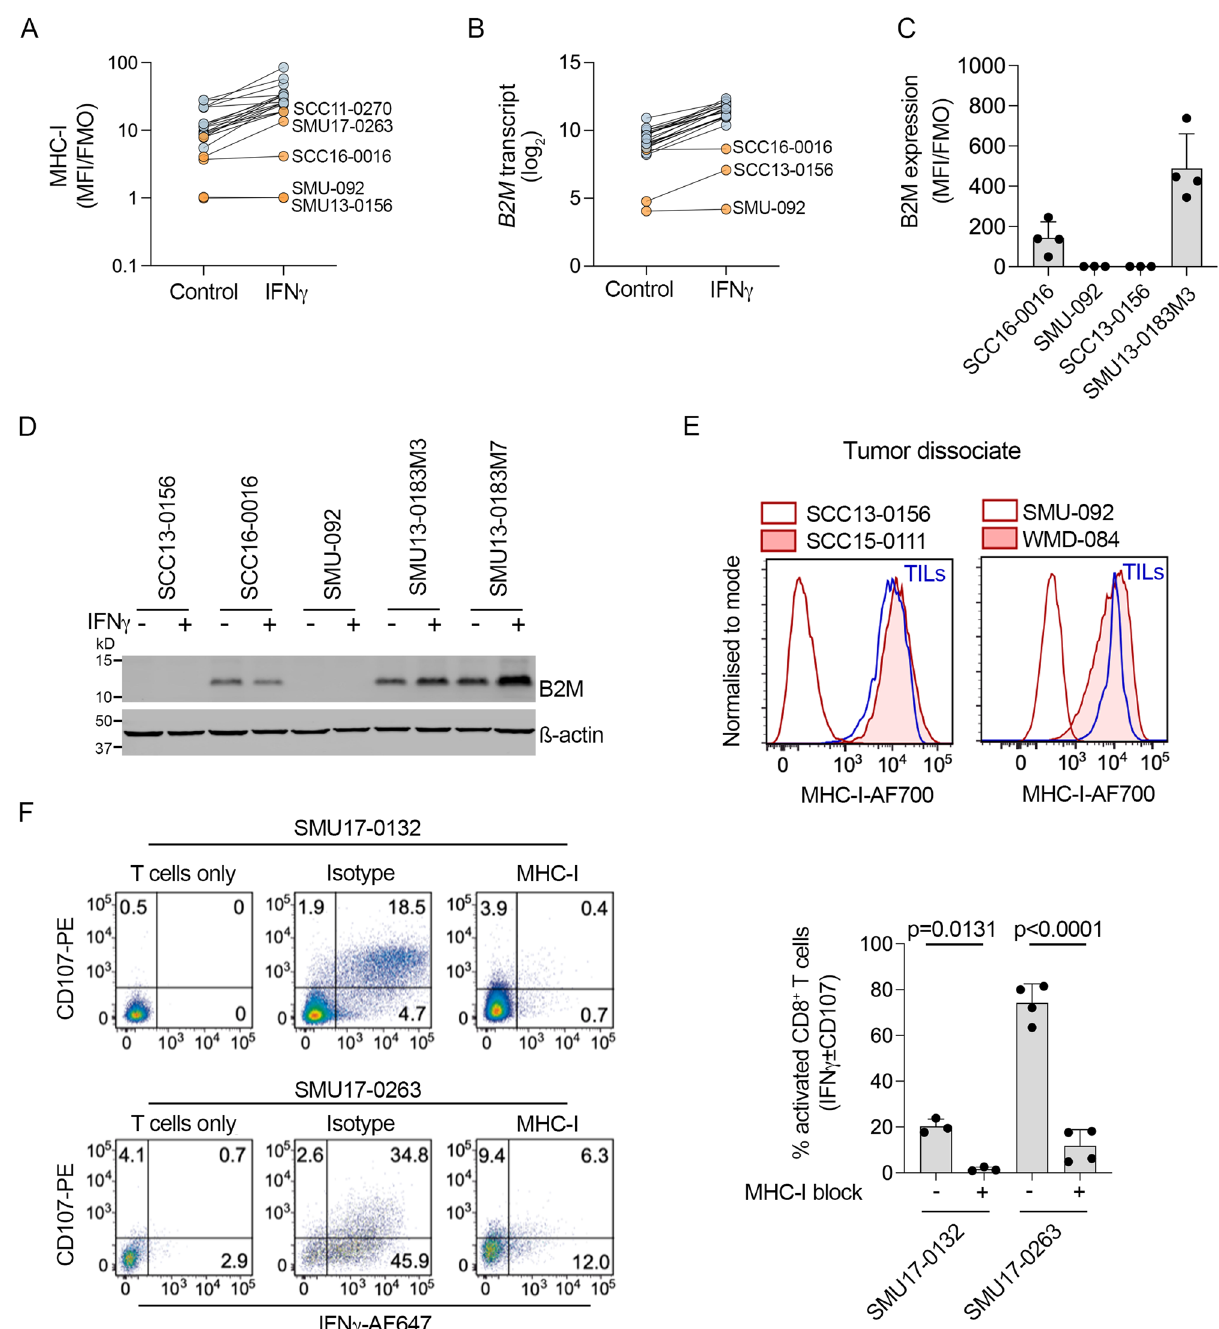
Fig. 5 | MHC-I expression in PD1 PROG cell lines. A Cell surface expression (median fl uorescenceintensitystained divided by fl uorescence minus one control, MFI/FMO) ofMHC-I in PD1PROGcelllines ( n =22) at72h after treatmentwith BSA control or IFN γ (1000 U/ml). Average of at least three biological replicates shown for each cell line. B B2M transcript expression at 24h after treatment of PD1 PROG cell lines ( n =22) with BSA control or IFN γ (1000 U/ml). C Cell surface expression (median fl uorescenceintensitystained divided by fl uorescence minus one control, MFI/FMO) of B2M on the SCC16-0016 ( n =4 biological replicates), SMU-092 ( n =3 biological replicates), SCC13-0156 ( n =3 biological replicates), and SMU13-0183M3 ( n =4 biological replicates) PD1 PROG cell lines at baseline. Individual values and mean±sd of biological replicates are shown. D Accumulation of B2M protein in 5 PD1 PROG cell lines 24h after treatment with BSA control ( − ) or IFN γ (1000 U/ml). Experiment repeated independently three times. E Representative histograms